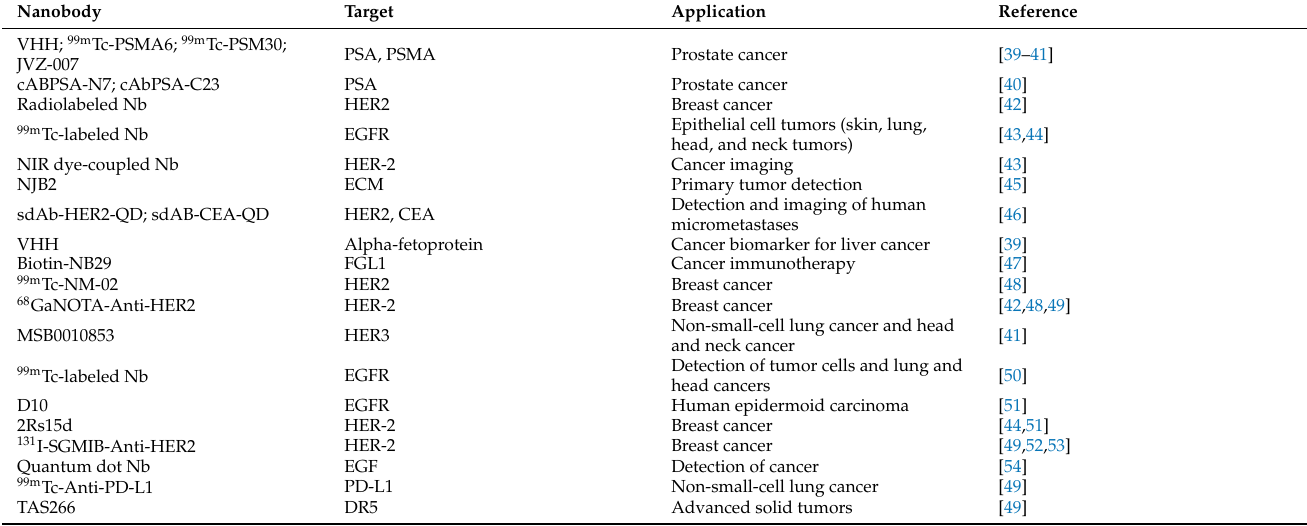
Table 7. Nanobodies used for cancer